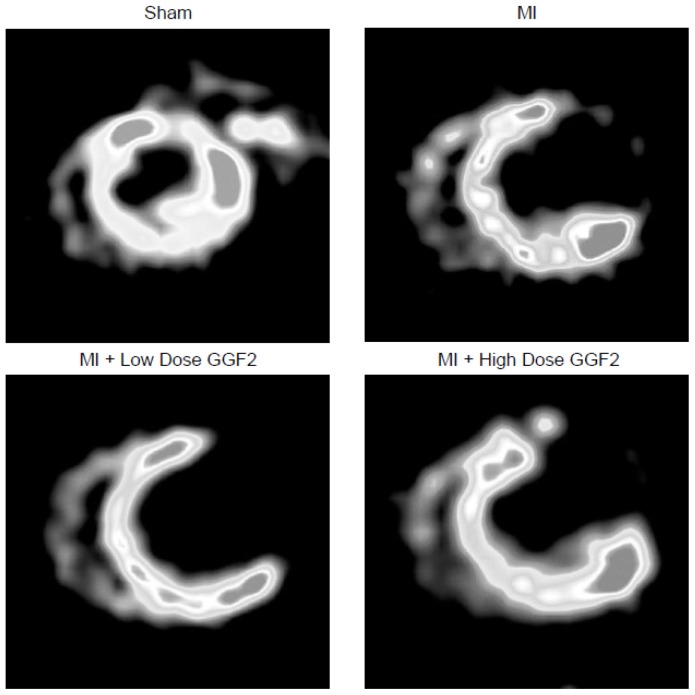
Effect of GGF2 treatment on myocardial PET glucose uptake.Short axis (transverse sections) images representative of sham, MI, and MI + GGF2 treated rats are displayed above. The sham rats showed prominent 18F-FDG uptake in all regions of the myocardium, whereas MI and MI + GGF2 treated rats show very little uptake in the infarct zone. Statistical analysis of cardiac standard uptake values was conducted by ANOVA, and results indicated that GGF2 treatment did not increase PET uptake in either remote or infarct regions (MI+LD, p = 0.79; MI+HD, p = 0.50).